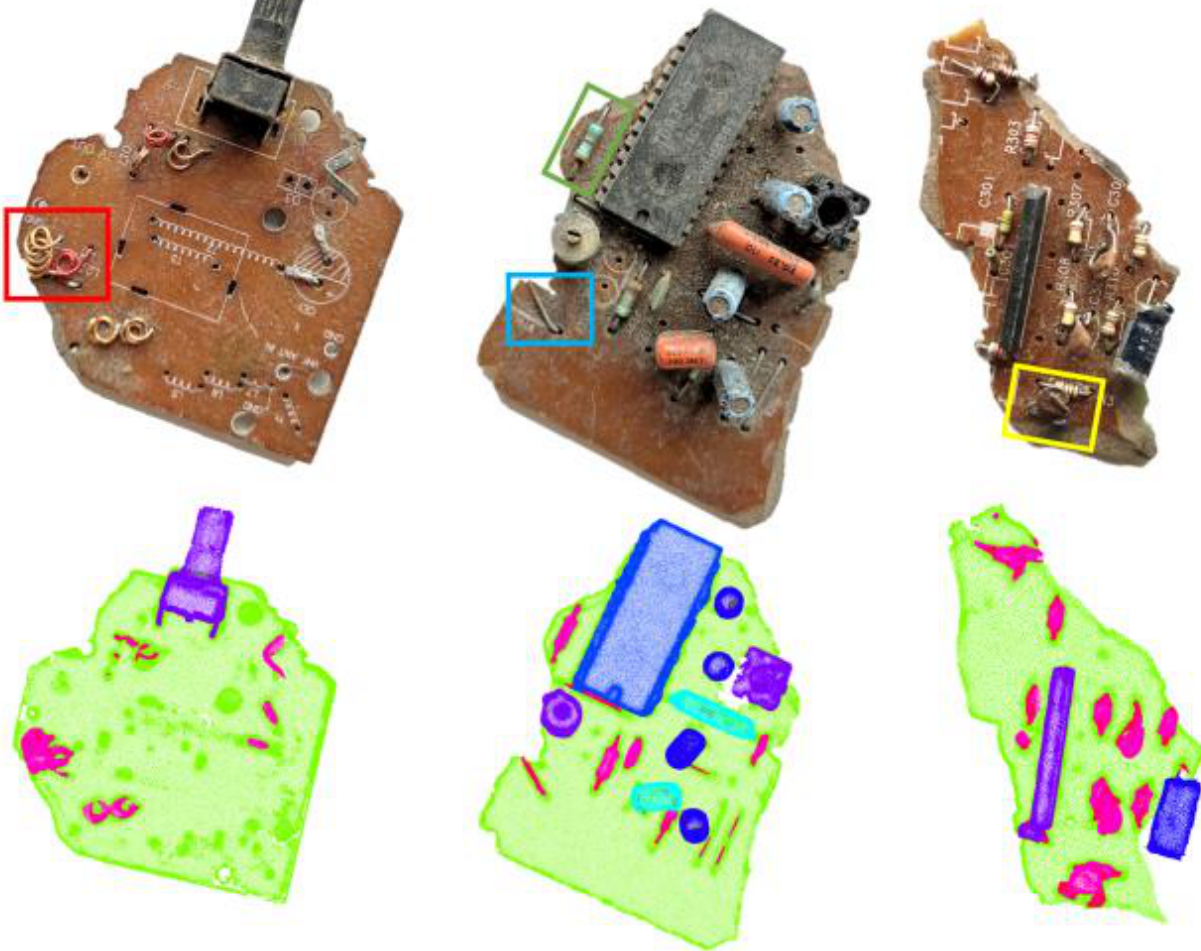
Figure 16. Small components such as metals (red and blue box), resistors (green box) and capacitors (yellow box) are difficult to distinguish because of limits in resolution. Nevertheless, they can be classified as components of a PCB due to the topological relationships provided by the 3D data.